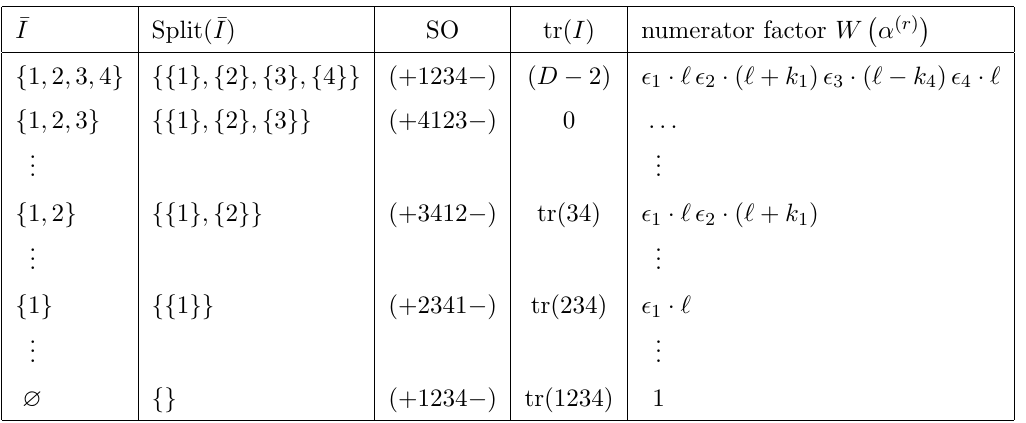
Table 2 . Contributions to the master numerator N